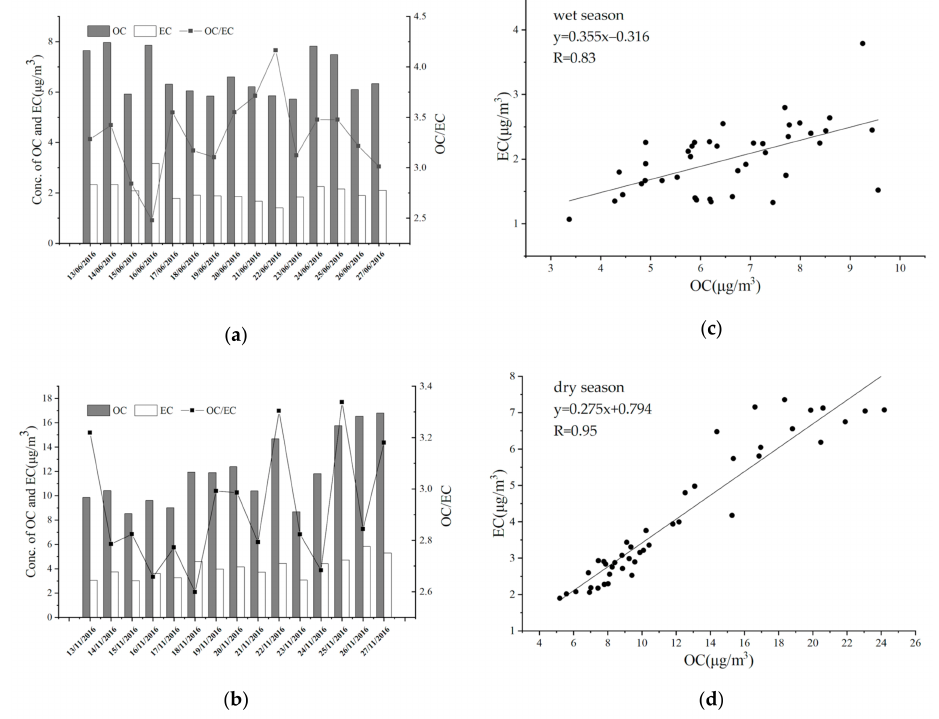
Figure 5. Concentrations of OC and EC, the value of OC/EC, and the relevance of OC and EC in PM 2.5 during the sampling period. ( a ) Concentrations of OC and EC in the wet season. ( b ) Concentrations of OC and EC in the dry season. ( c ) The value of OC/EC and the relevance of OC and EC in PM 2.5 during the wet season sampling period. ( d ) The value of OC/EC and the relevance of OC and EC in PM 2.5 during the dry season sampling